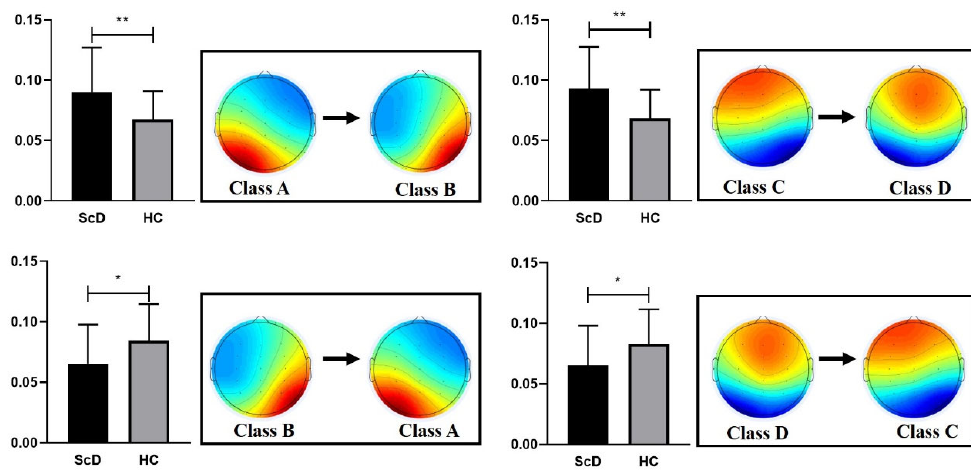
Figure 2. The four microstate classes significant transitions. *: p < 0.05, **: p < 0.01.